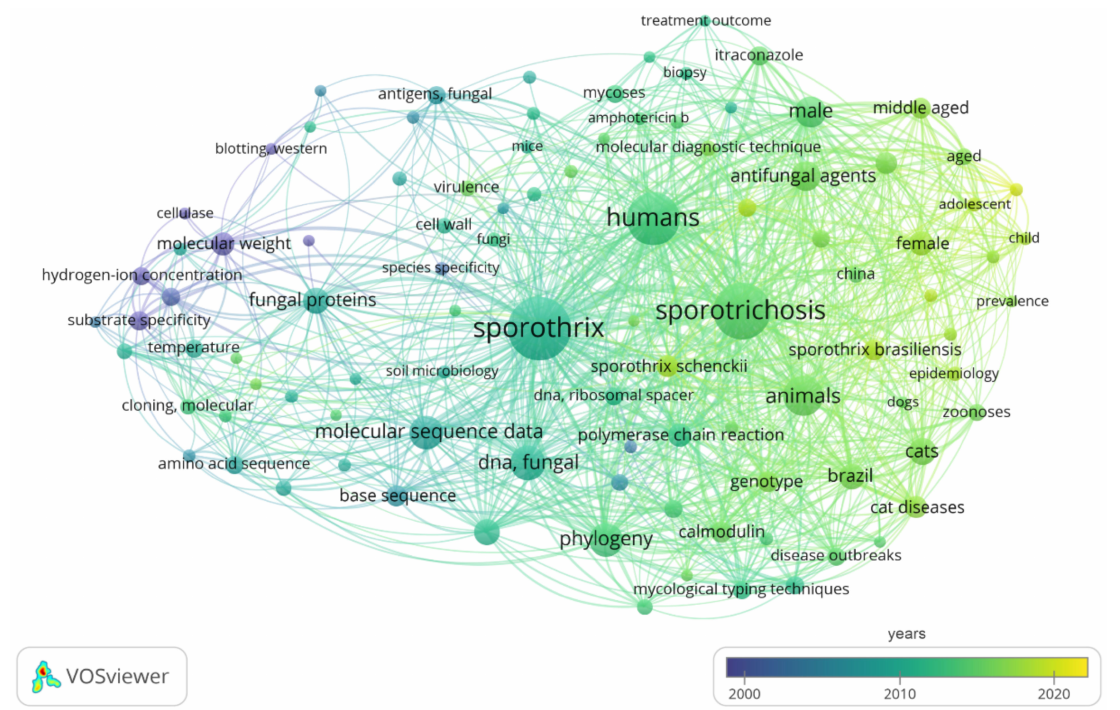
Figure 7. Bibliometric analysis in the molecular diagnostics of sporotrichosis through the software VOSviewer v1.6.13. Network of the 101 keywords co-occurrence found in Pubmed search for molecular diagnosis of